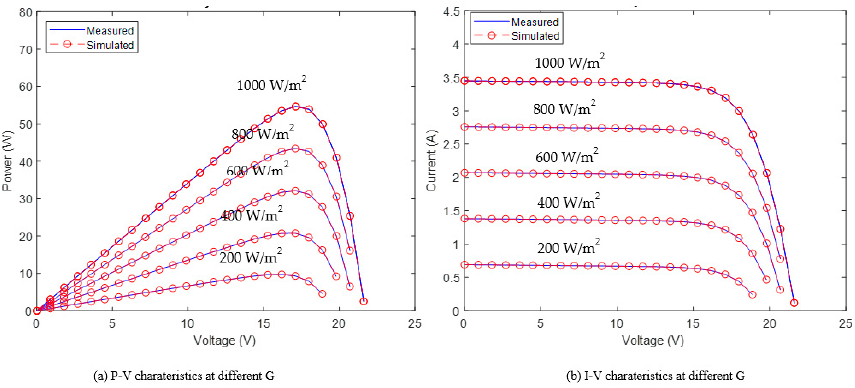
Figure 14. Depiction of the principal characteristics on SM55 module.